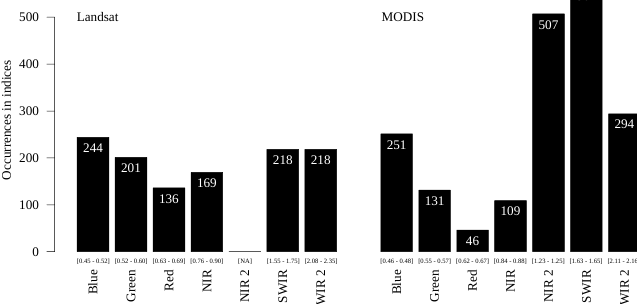
Figure 15. Distribution of the frequencies of the spectral bands of the learned indices for evergreen forest/semi-deciduous forest discrimination.